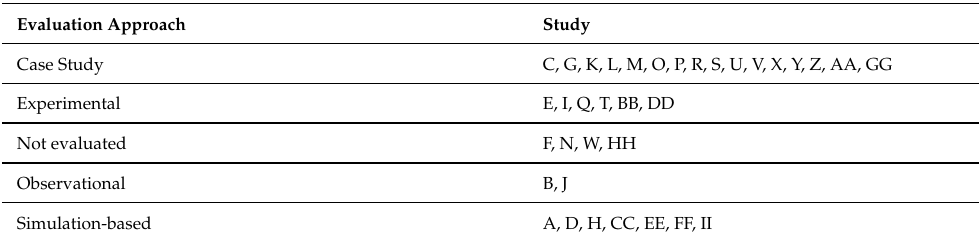
Table 9. Approaches to evaluation of the